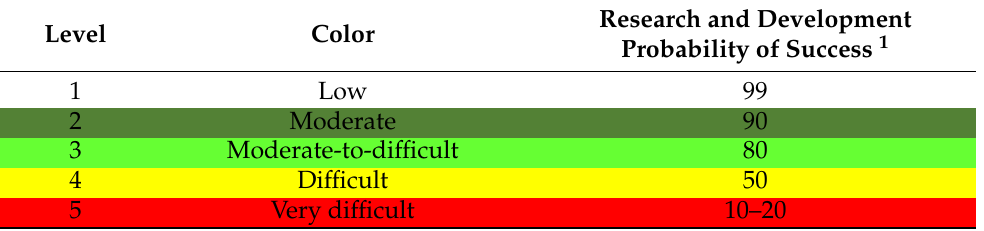
Figure 3. Technology Complexity Levels (see Table 1) for radio frequency and optical communication systems for various curves of constant equivalent isotropic radiated power, ( a ) RF communications systems, ( b ) Optical communication systems. Table 1. Technical Risk in Terms of Complexity.